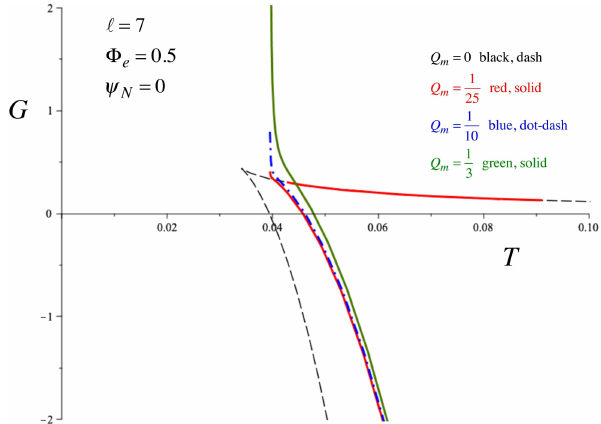
as Q m increases. N